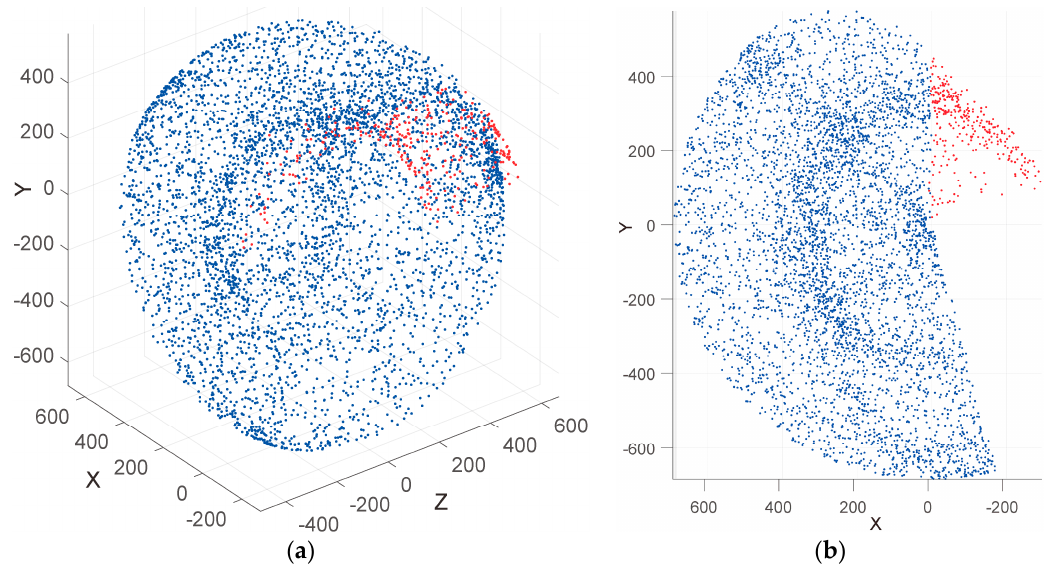
Figure 8. Inverse kinematics workspace (mm): (a) Isometric view; and (b) right view.